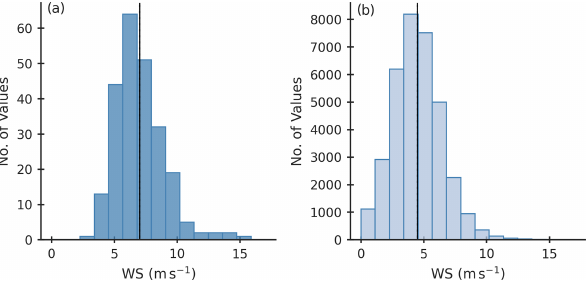
Figure A1. Histograms showing (a) the daily maximum values and (b) the 10min mean values for all sampling days of 2017, 2018 and 2019. The black line indicates the mean.